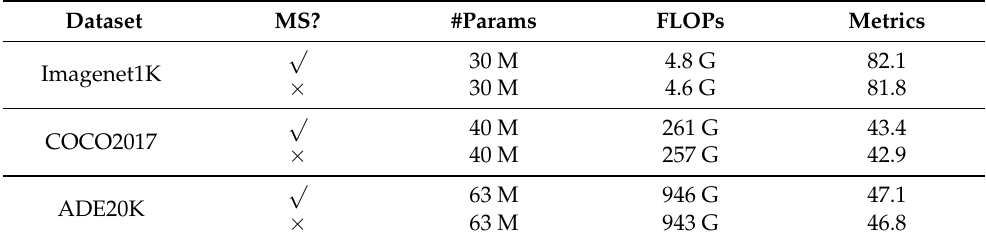
Table 7. Effectiveness of the proposed multi-scaled (MS) dilated pooling in the GSA module. Metrics on Imagenet1K is top-1 accuracy, on COCO2017 is AP b , and on ADE20K is mIoU.